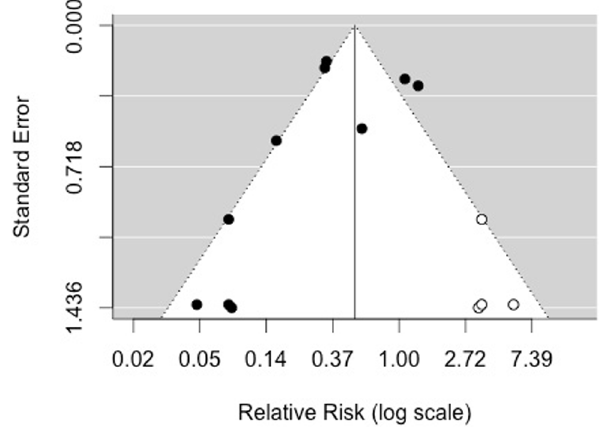
Figure 3. Funnel plot ‘‘trim and fill’’ technique assessing publication bias for overall incidence of severe mucositis. The x-axis represents the risk ratio for the effect of low level laser therapy and the y-axis represents the inverse of the variance of the effect. Estimated number of missing studies on right side=4.